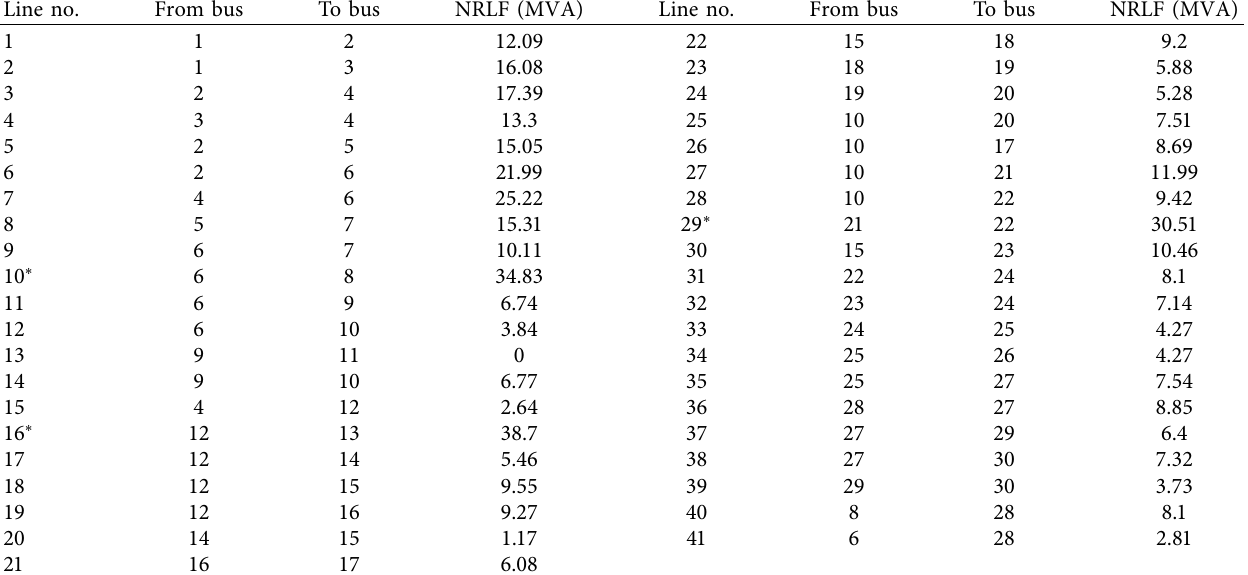
Table 2: Transmission line fows (MVA) after